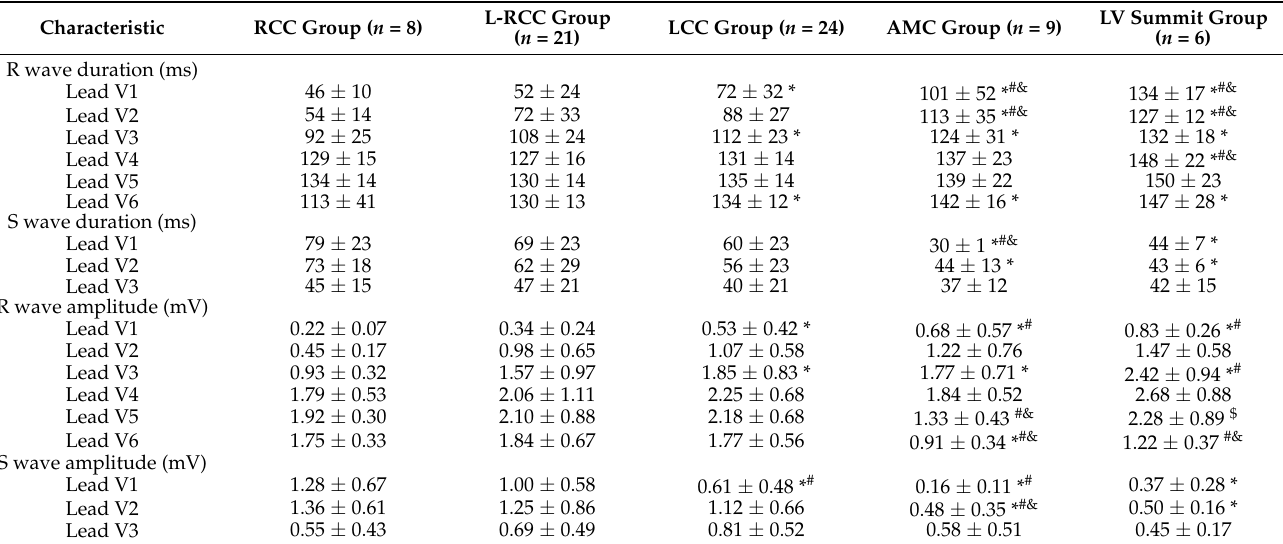
Table 3. Comparison of ECG characteristics of precordial